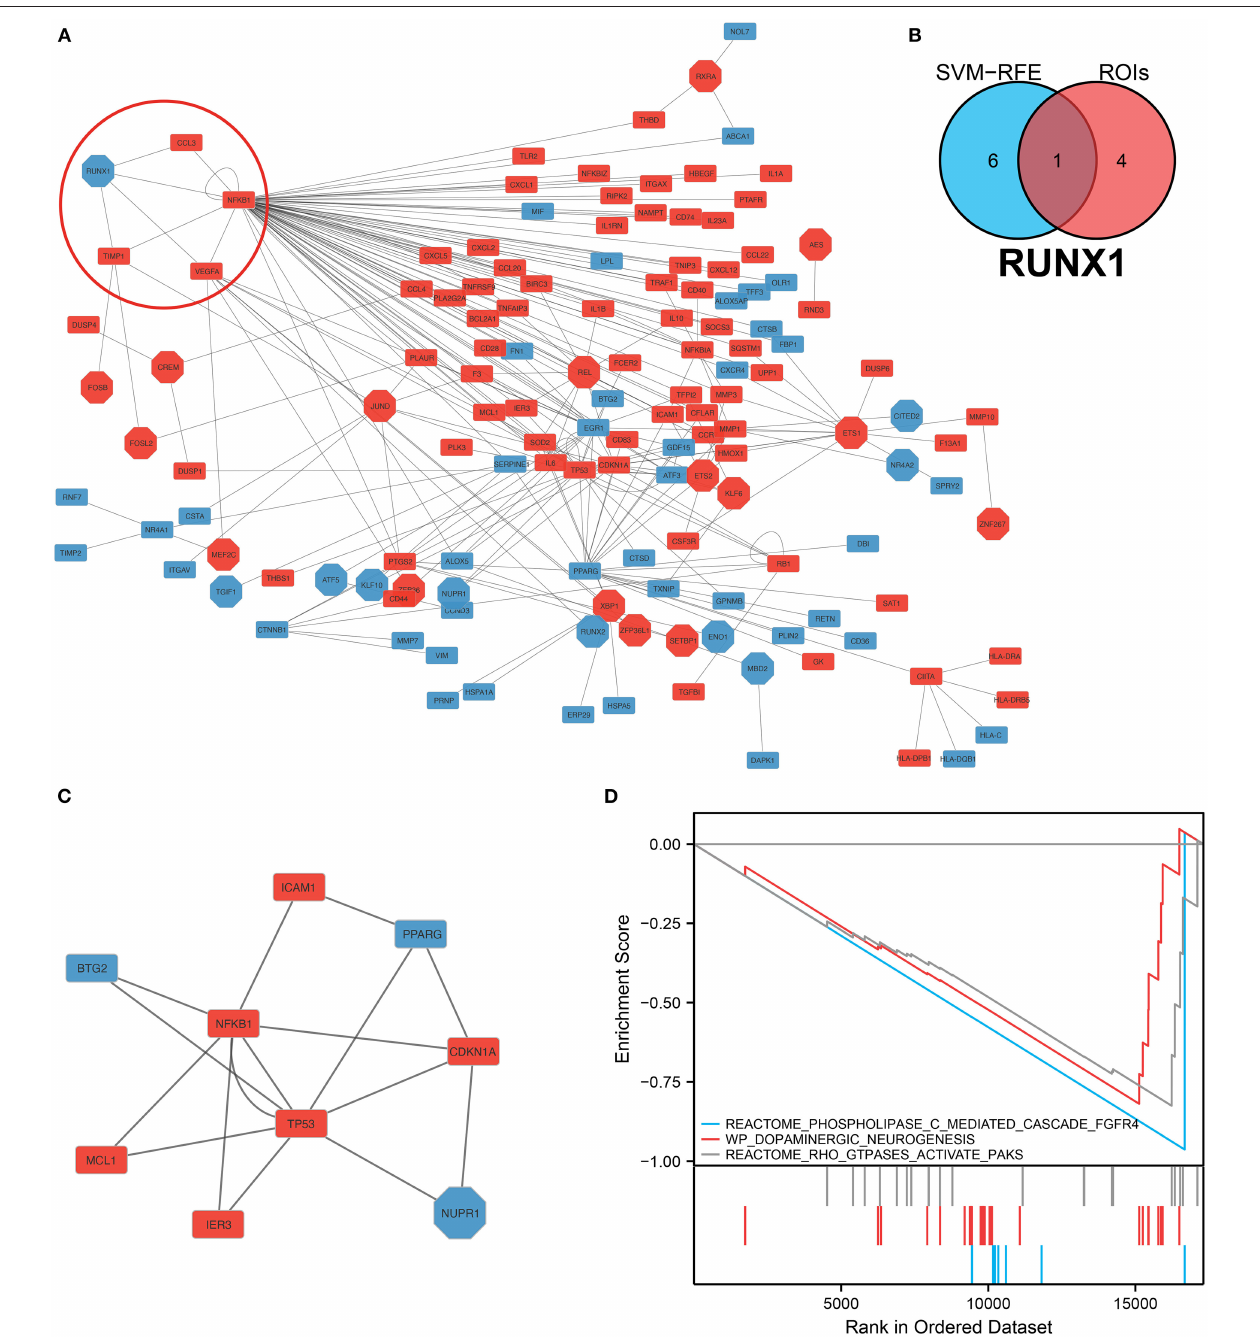
FIGURE 6 | Construction of the protein–protein interaction network and hub gene screening. (A) TF-mRNA protein–protein interaction network in monocytes/macrophages. The red circles denote the RUNX1 and target genes. (B) Intersection analysis of the seven genes screened using the SVM–RFE model, and these five regions of interest yielded the hub gene RUNX1 . (C) Sub-protein–protein interaction network showing that NFKB1 , which is regulated by RUNX1 , is the hub gene in this PPI network. (D) Gene Set Enrichment Analysis of RUNX1 at the single-cell level. megakaryocyte differentiation and platelet function. Therefore, samples with upregulated RUNX1 expression, nonalcoholic RUNX1 plays a complex role in IA progression. Further, it fatty liver disease, oxidative phosphorylation, RUNX1 regulates might be involved in IA progression via the regulation of HSC the transcription of genes involved in the differentiation of differentiation and platelet production and might play a potential HSCs and those involved in megakaryocyte differentiation, and regulatory role in oxidative platelet function pathway RUNX1 regulates genes involved in